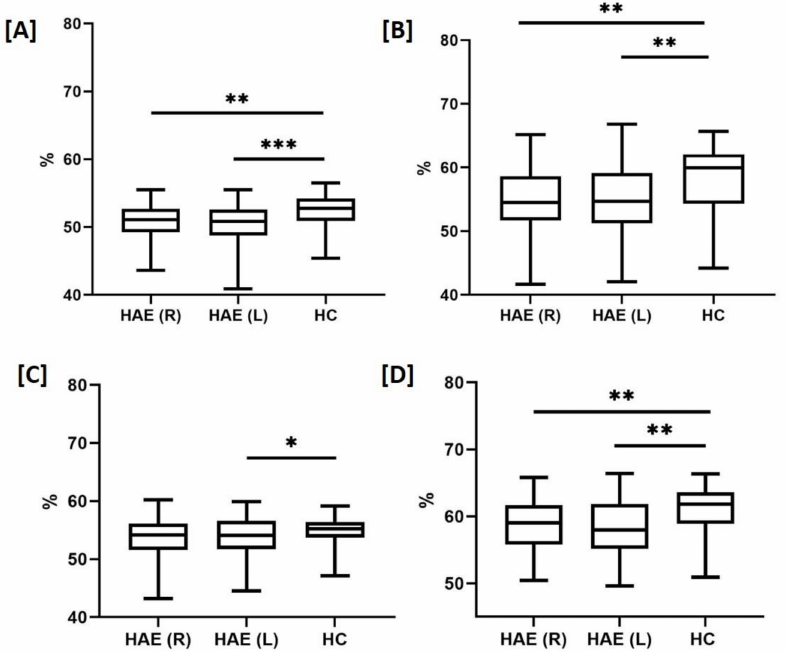
Figure 4. Retinal capillary plexi by optical coherence tomography angiography from the study population. Compared to healthy controls (HC), patients with hereditary angioedema (HAE) showed in both the right (R) and the left (L) eyes a lower capillary density at the both the superficial ( A ) and the deep ( B ) whole images, as well as at the superficial ( C ) and deep ( D ) parafoveal areas. The vascular density was compared between HAE and HC using the parametric unpaired T test or the nonparametric Mann-Whitney U test when appropriate. p < 0.05 (*) were considered significant, ** p < 0.01, *** p <